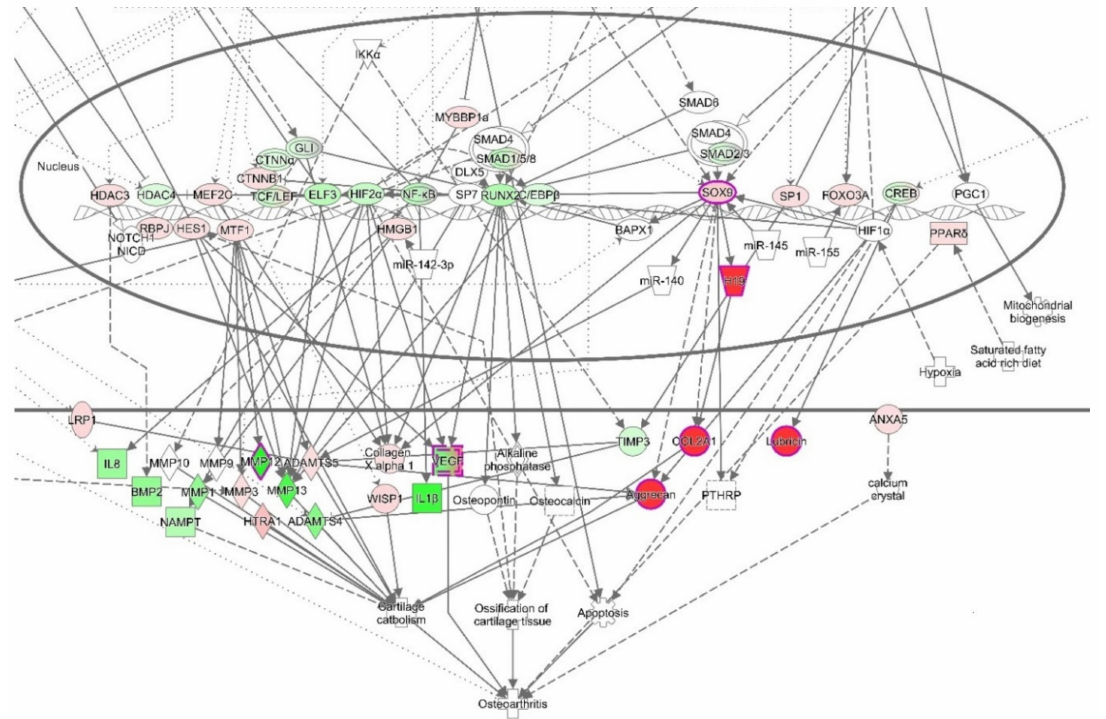
Figure 8. The canonical pathway “Osteoarthritis Signaling” for Epi C vs. Ctr treatment group. This canonical pathway has been described as a critical regulatory element for the onset of osteoarthritis. Based on the activation z-score ( p -value = 1.45 × 10 − 3 , z-score = − 1.213), the normal function of this pathway is reduced. Noteworthy is the downregulation of NF- κ B (expected activation) and the upregulation of SOX9 (expected inhibition). Red fillings = “activated”, green fillings = “inhibited”, purple highlights = passed cut-o ff s, no highlight = did not pass cut-o ff